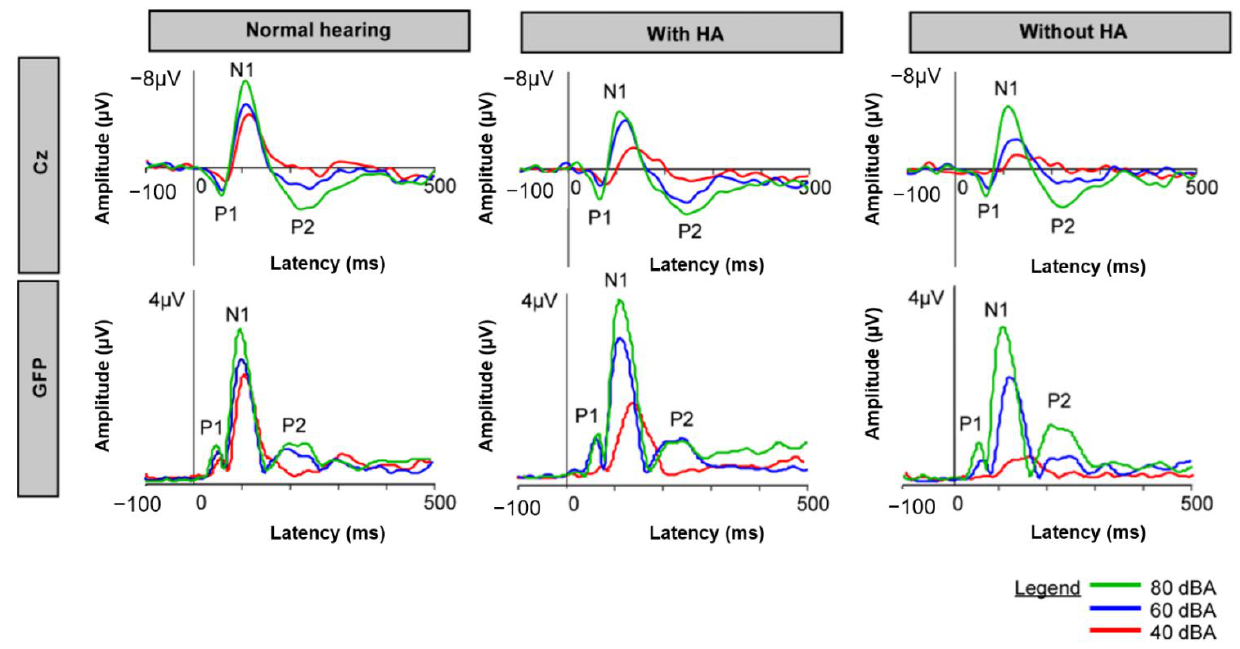
Figure 3. Mean CAEP responses recorded at Cz ( top ) or for GFP ( bottom ) with a 1-kHz tone burst presented at 40, 60, or 80 dBA for the NH group and the HA group (aided and unaided). Table 2. Mean ± standard deviation for peak CAEP amplitude and latency at Cz electrode and for global field power (GFP), for the NH group and the HA group (aided or unaided) at each intensity. Intensity